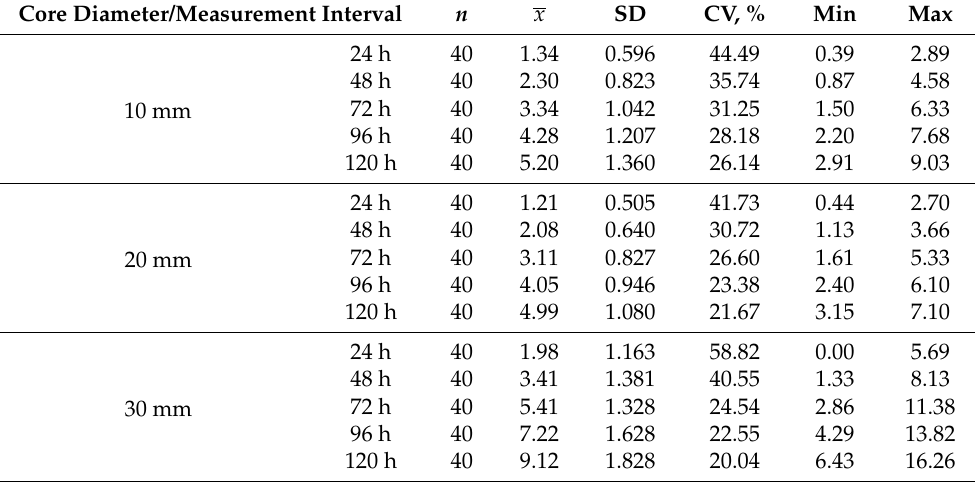
Table 2. Means ( x ) with standard deviation (SD), coefficients of variation (CV), minimum (Min), and maximum (Max) for the drip loss of chicken breast meat in relation to horizontal fiber direction, core diameter (10, 20, and 30 mm), and measurement interval (24, 48, 72, 96, and 120 h). Core Diameter/Measurement